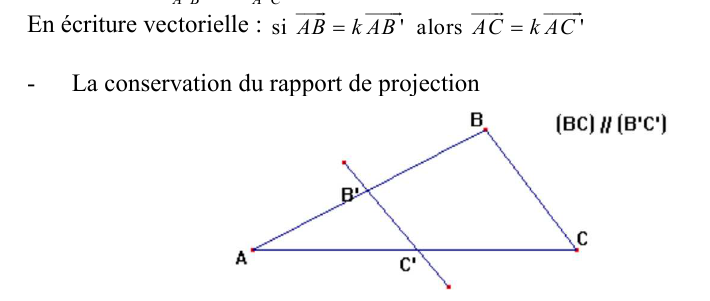
Fig. 3. Conservation du rapport de projection.